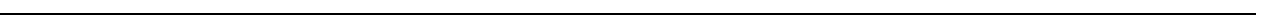
Fig. 4 DNA damage-induced BRE-USP7 interaction stabilizes CDC25A. a Ubiquitylation of FLAG-CDC25A in cells harvested 4 h after 6 Gy IR in absence (lanes 1 – 4) or presence (lanes 5, 6) of exogenous BRE. CDC25A was immuno-precipitated using anti-FLAG antibody (lanes 1, 2, 5, 6), IgG was used as control (lanes 3, 4). b MCF7 cells stably expressing CRE-inducible HA-BRE were transfected with either non-speci fi c (NS, lanes 1 – 2 and 7 – 8) or two independent USP7-speci fi c (USP7 #1, lanes 3, 4, 9, 10 and USP7 #2, lanes 5, 6, 11, 12) siRNAs along with or without plasmids expressing CRE and irradiated with 6 Gy IR. Western blot shows the abundance of endogenous CDC25A in non-IR cells and 4 h after irradiation. HDM2 was used as a control for USP7 knockdown. c FLAG-CDC25A ubiquitylation in cells harvested 4 h after 6 Gy IR in absence (lanes 1 – 3) or in presence of exogenous USP7 (lanes 4, 5) or catalytic inactive USP7 (USP7-CS; lanes 6, 7). Anti-FLAG antibody (lanes 2 – 7) was used to pull down CDC25A, IgG was used as control (lane 1). HDM2 was used as a control for USP7 activity. d Co-immunoprecipitation of FLAG-CDC25A, BRE, and endogenous USP7 from MCF7 cells using anti-BRE antibody (lanes 1 – 4) and IgG antibody (lanes 5 – 6); 5 μ M MG132 was added after irradiation to increase CDC25A level and harvested after 2 h. e Model depicting the interaction of BRE, CDC25A, and USP7. In presence of DNA breaks, BRE interacts with USP7 and then BRE, USP7, and CDC25A complex is formed. For simplicity, MERIT40 is not included in the model. f Co-immunoprecipitation of USP7 and different deletion mutants of BRE tagged with HA-epitope from irradiated HEK293 cells using USP7 antibody. Top panel shows the schematic representation of different deletion mutants of BRE. Numbers in the top panel mark different USP7 binding motifs. Stars indicate different HA-BRE proteins. g Western blots showing IR-induced degradation of CDC25A after expressing HA-BRE or HA-BRE mutant defective in USP7 binding (FL Δ 123). GAPDH was used as a loading control for all blots. Histogram represents mean ± s.d. values of relative band intensities. P values are calculated using the paired two-tailed t -test and presented in Supplementary Table